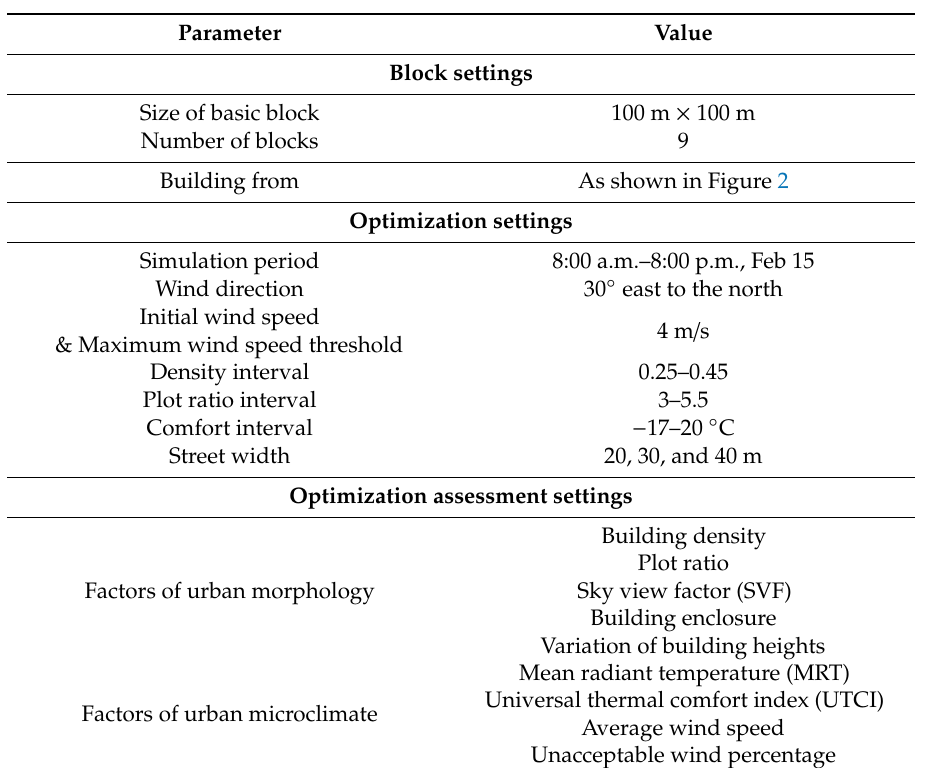
Table 2. Parameter settings and boundary conditions during optimization.